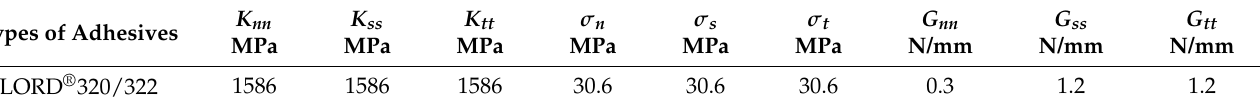
Table 2. Adhesive performance parameters.